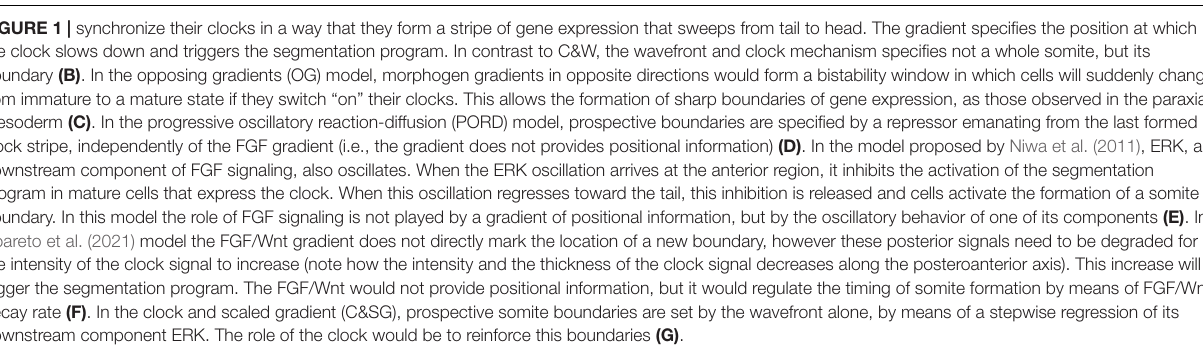
FIGURE 1 | synchronize their clocks in a way that they form a stripe of gene expression that sweeps from tail to head. The gradient specifies the position at which the clock slows down and triggers the segmentation program. In contrast to C&W, the wavefront and clock mechanism specifies not a whole somite, but its boundary (B) . In the opposing gradients (OG) model, morphogen gradients in opposite directions would form a bistability window in which cells will suddenly change from immature to a mature state if they switch “on” their clocks. This allows the formation of sharp boundaries of gene expression, as those observed in the paraxial mesoderm (C) . In the progressive oscillatory reaction-diffusion (PORD) model, prospective boundaries are specified by a repressor emanating from the last formed clock stripe, independently of the FGF gradient (i.e., the gradient does not provides positional information) (D) . In the model proposed by Niwa et al. (2011), ERK, a downstream component of FGF signaling, also oscillates. When the ERK oscillation arrives at the anterior region, it inhibits the activation of the segmentation program in mature cells that express the clock. When this oscillation regresses toward the tail, this inhibition is released and cells activate the formation of a somite boundary. In this model the role of FGF signaling is not played by a gradient of positional information, but by the oscillatory behavior of one of its components (E) . In Boareto et al. (2021) model the FGF/Wnt gradient does not directly mark the location of a new boundary, however these posterior signals need to be degraded for the intensity of the clock signal to increase (note how the intensity and the thickness of the clock signal decreases along the posteroanterior axis). This increase will trigger the segmentation program. The FGF/Wnt would not provide positional information, but it would regulate the timing of somite formation by means of FGF/Wnt decay rate (F) . In the clock and scaled gradient (C&SG), prospective somite boundaries are set by the wavefront alone, by means of a stepwise regression of its downstream component ERK. The role of the clock would be to reinforce this boundaries (G)